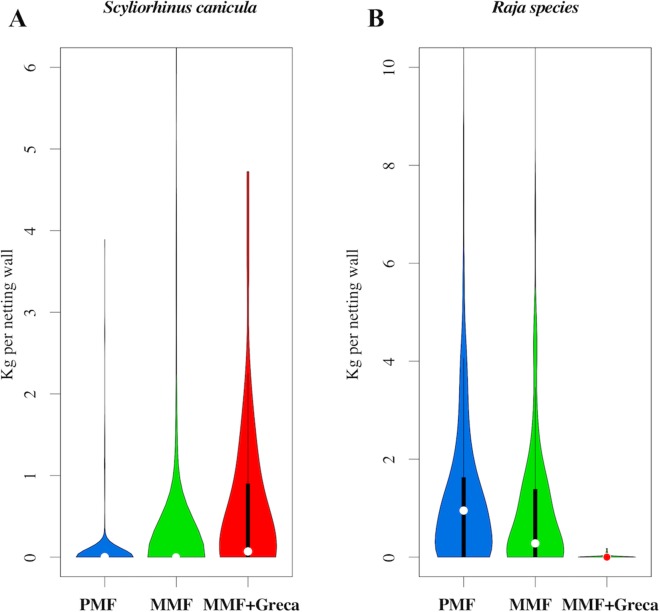
Abundance distribution (kilogram per netting wall) of the species that contributed most to the differences in the discarded fraction between the different types of manufactured netting walls.(A) S. canicula; (B) Raja species.